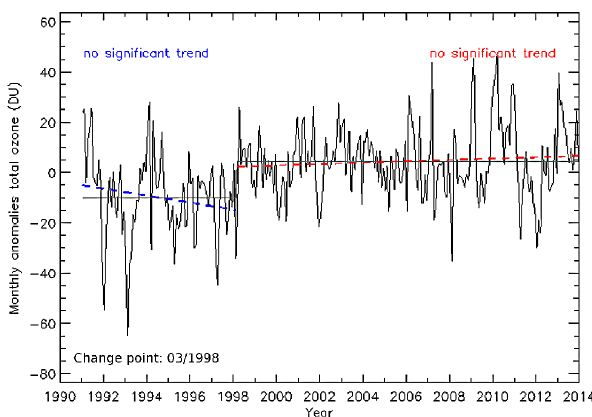
Figure 6. The black line represents the time series of monthly anomalies of total ozone column (1991–2013). The blue (dashed) line represents the (insignificant) negative trend before the detected change point, and the red (dashed) line represents the (insignificant) positive trend after the change point. The grey lines represent the mean before and after the change